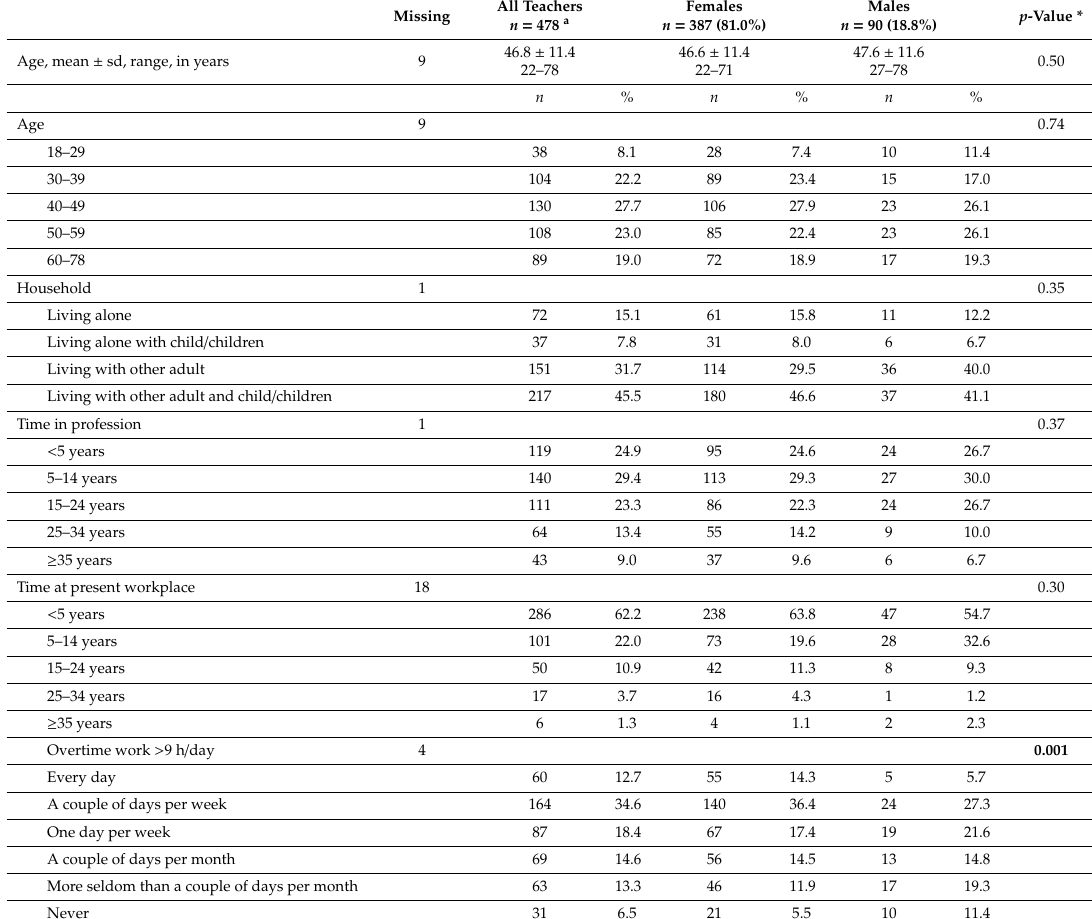
Table 1. Individual characteristics for teachers at